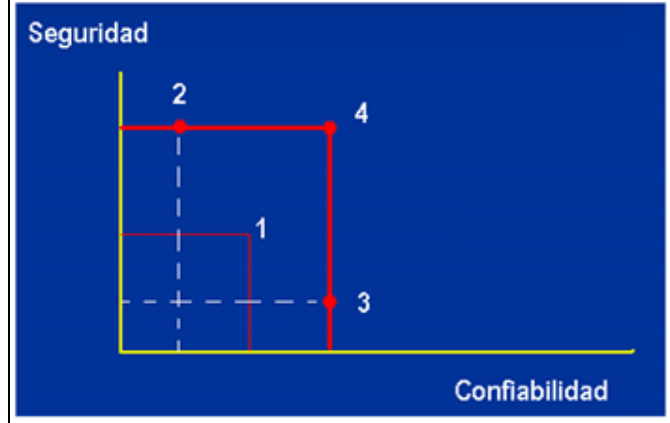
Figura 1: Relación entre seguridad y confiabilidad. Fuente: Autor,